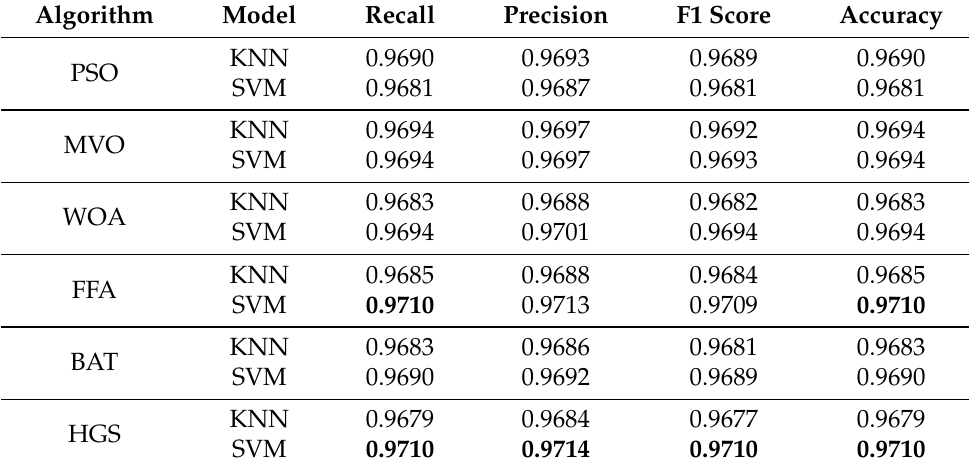
Table 5. Results of each algorithms on C36